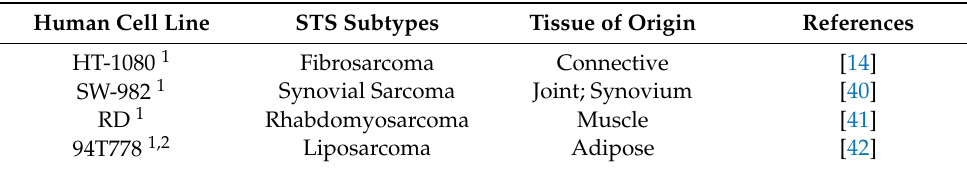
Table 1. A list of the four human STS cell lines utilized in this study. Human Cell